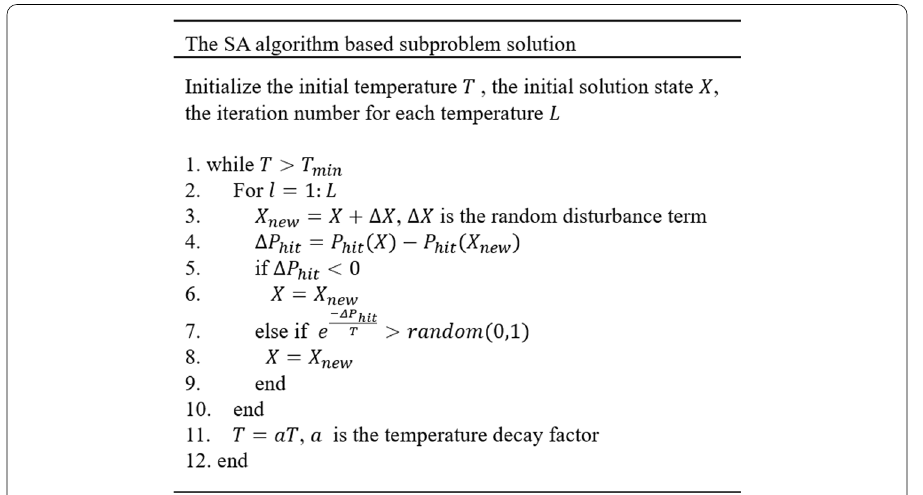
Fig. 2 The SA algorithm based subproblem